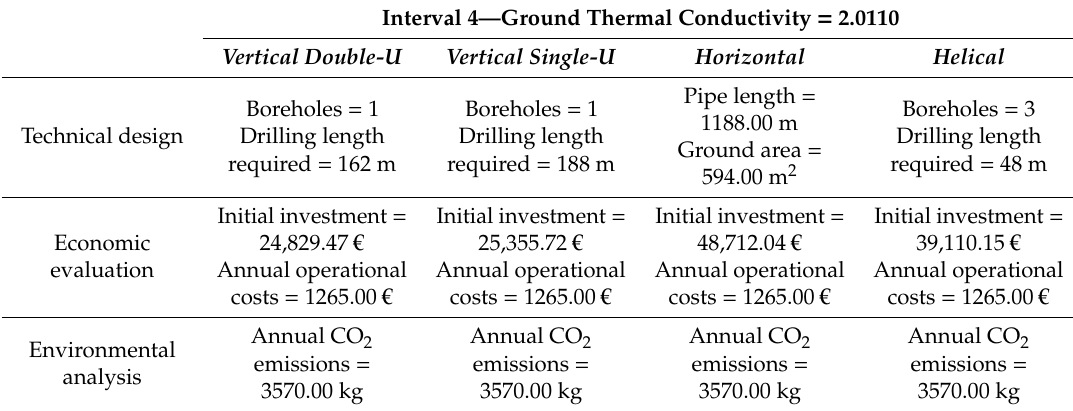
Table 8. Design provided by GES-CAL software for the geothermal system under study, interval 4.